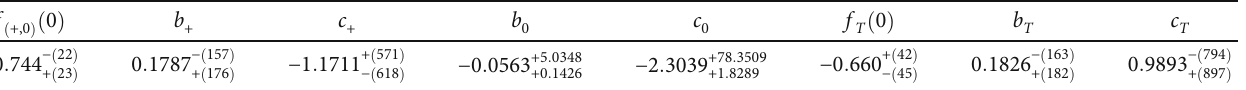
, c Þ in Eq. (52) for the D ⟶ K decay with m j j